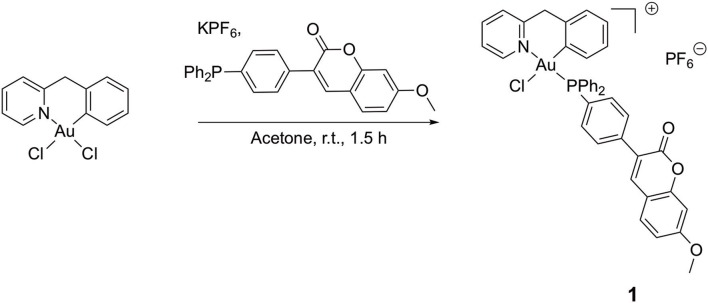
Synthesis of compound [Au(pyb-H)(PPh2Ar)Cl]PF6 (PPh2Ar = 3-[4 (diphenylphosphino)phenyl]-7-methoxy-2H-chromen-2-one] 1.